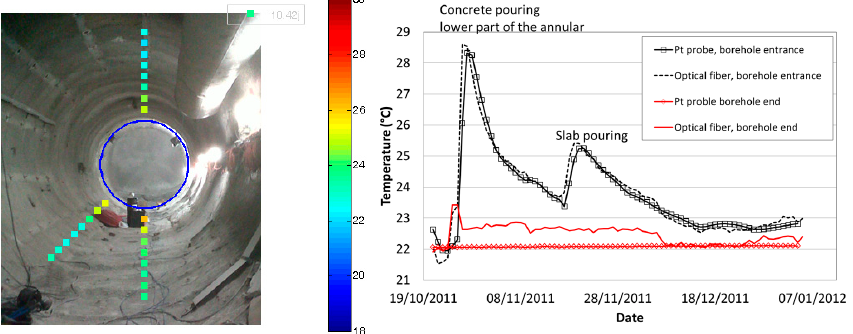
Figure 15. Distributed temperature measurement obtained with Raman OFS during concrete liner pouring ( left ) and comparison with collocated platinum probes as a function of time during concrete liner pouring ( right ).